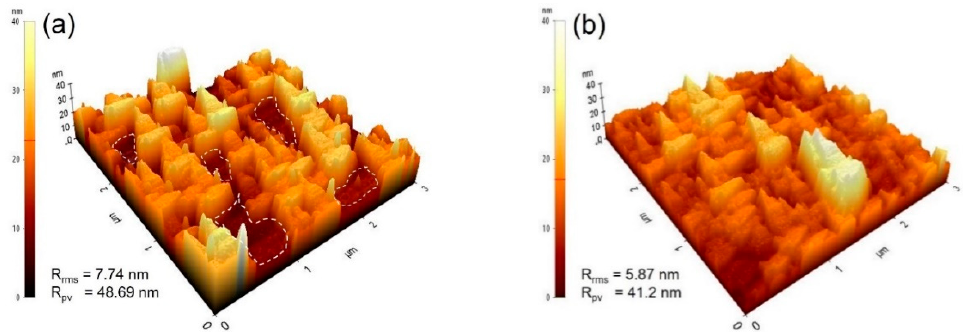
Figure 4. Atomic force microscopy (AFM) images (scan size: 3 × 3 µ m) showing the microstructural surface differences between the ( a ) as-deposited and ( b ) oxidized Si/sapphire films at 823 K.